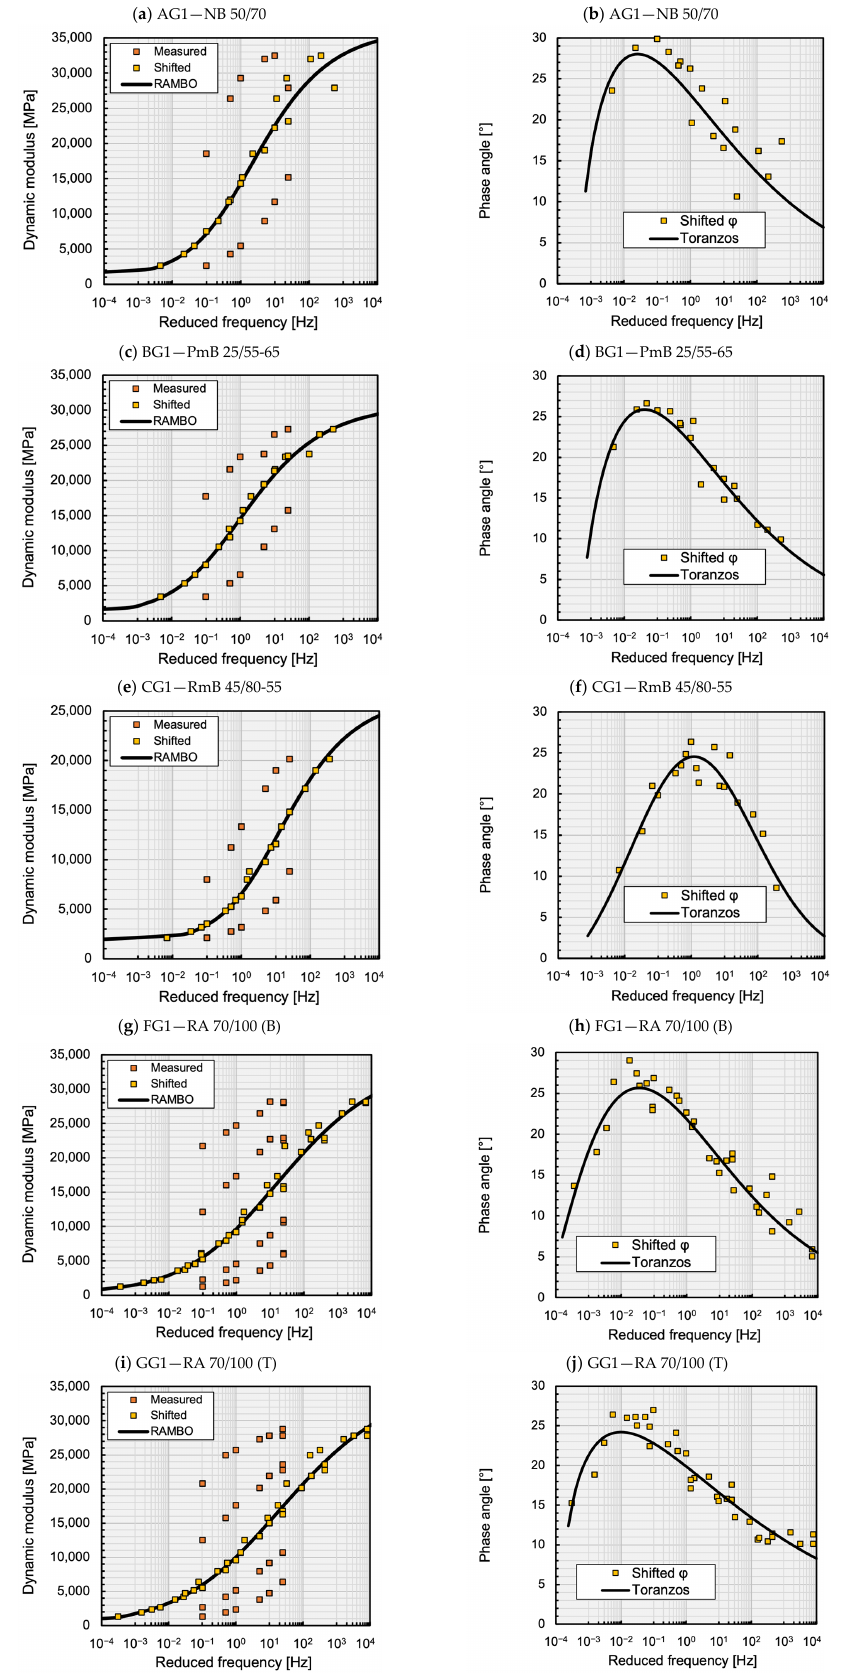
Figure 3. Dynamic modulus ( a , c , e , g , i ) and phase angle ( b , d , f , h , j ) master curves for T 0 = 20 °C. Figure 4b shows the comparison of the 𝜙 phase angle values of the analysed asphalt mixtures by plotting the laboratory measurements and predictions of the Toranzos model, again based on 318 data points (the same data points as in Figure 4a). The measured phase angle varied between 5° and about 30°. The phase angle values predicted by the Toranzos model have shown a strong linear correlation with the measured values, although, in gen- eral, the predicted phase angle values have been slightly lower, compared to the measured values. These results indicate that the Toranzos model can predict the phase angle with good accuracy. Nevertheless, the overall accuracy of the prediction of the phase angle is lower ( R 2 = 0.8956) than in the case of the prediction of the dynamic modulus, which can be explained by the lower accuracy of the phase angle data. This fact is verified by former studies, stating that, sometimes, it is impossible to construct a smooth master curve for the phase angle data [2,36]. The arbitrarily chosen log-linear 𝛼 (cid:3021) shift factor for the construction of the master curves proved to be suitable in the cases of all the asphalt mixtures analysed. The relation- ship between the logarithm of the shift factor ( log𝛼 (cid:3021) ) and the temperature ( 𝑇 ) remained linear within the analysed temperature range in the cases of all the asphalt mixtures ana- lysed.